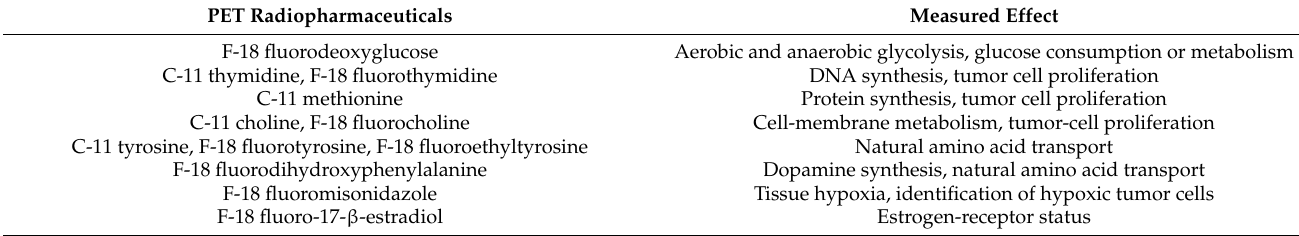
Figure 6. ‘Territorial management’ of cancers. This concept involves using specific PET probes which identify the dominant pathways on tumor cells. The same ligands could then be used for targeting a therapeutic radionuclide for treatment of the cancers. Effective and ‘ideal’ therapy strategies should/must target all the elements simultaneously and monitor genetic mutations/signatures during therapy as well. CD44 = cluster of differentiation 44, DMPO = dimethylpyrrolineoxide, DNA = deoxyribonucleic acid, FAP (I) = fibroblast-activation-protein (inhibitors), GRPR = gastrin-releasing peptide receptor, MMP = matrix metalloproteinase, PD = programmed cell death protein, PDL-1 = programmed death-ligand 1, PSMA = prostate-specific membrane antigen, RNA = ribonucleic acid, SSTR = somatostatin receptor, VEGF = vascular endothelial growth factor. Table 4. Overview of possible PET radiopharmaceuticals and their measured effects for functional imaging. AKT = ser- ine/threonine protein kinase, CTLA-4 = cytotoxic T-lymphocyte-associated protein 4, CXCR-4 = chemokine receptor type 4, DNA = deoxyribonucleic acid, EGFR = epidermal growth factor receptor, FAPI = fibroblast-activation-protein inhibitors, GLP 1 = glucagon-like peptide 1, GRPR = gastrin-releasing peptide receptors, HER-2 = human epidermal growth factor receptor, PD-1 = programmed cell death protein, PDL-1 = programmed death-ligand 1, PIK3 = phosphoinositide 3-kinase, PSMA = prostate-specific membrane